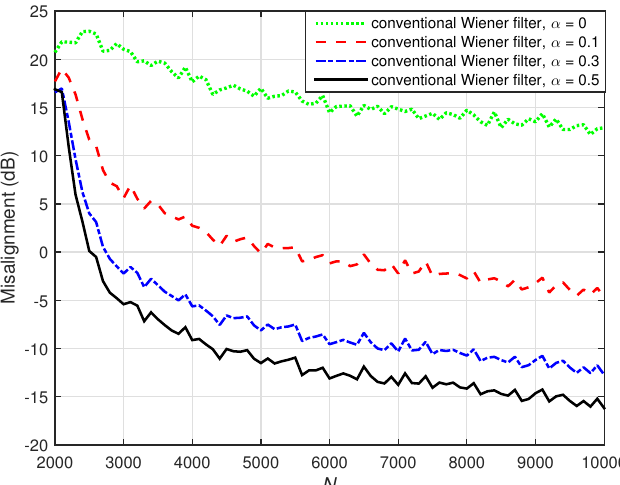
Figure 17. Performance of the conventional Wiener filter for different values of N (number of available data samples to estimate the statistics) and different values of α (the distortion parameter). The source signal (white Gaussian noise) was preprocessed with positive and negative half-wave rectifiers. The numbers of channels were M = 2 (stereophonic scenario), L = 1024, and SNR = 30 dB.